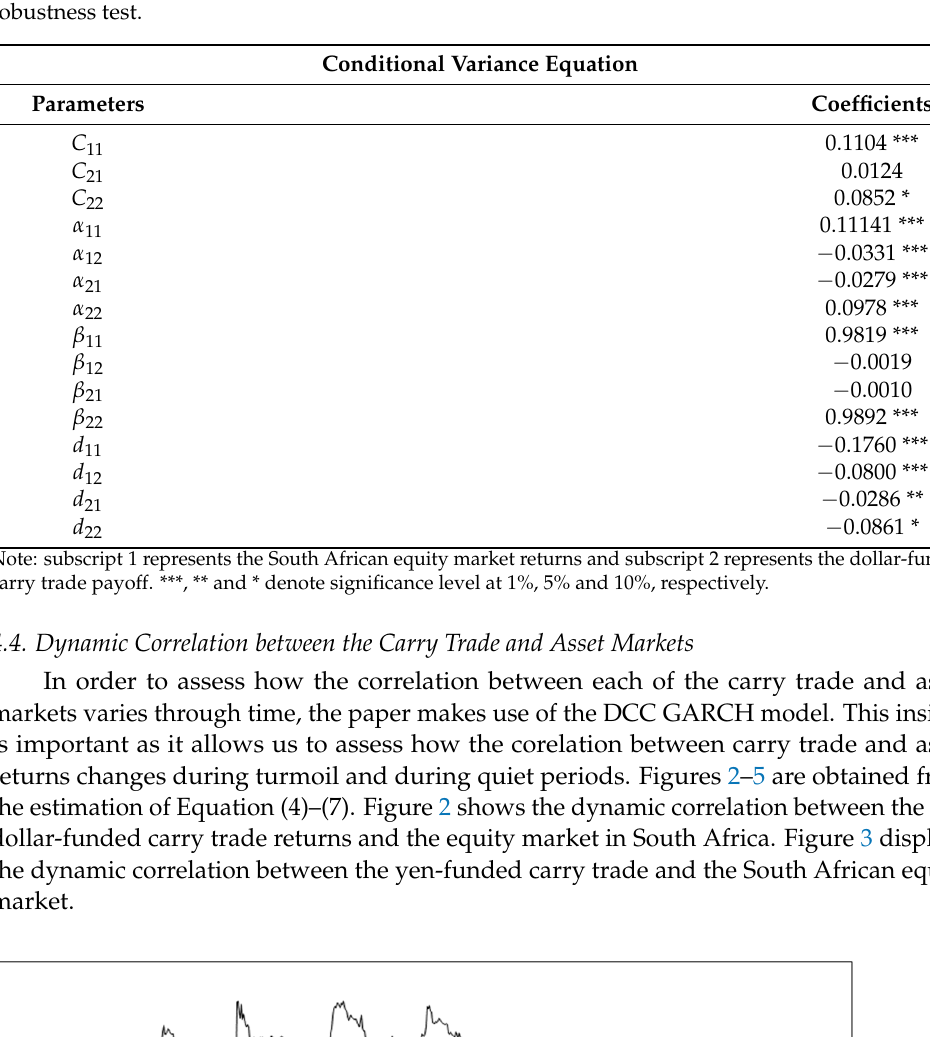
Figure 3. Dynamic correlation between the South African equity market and the yen-funded carry trade returns.